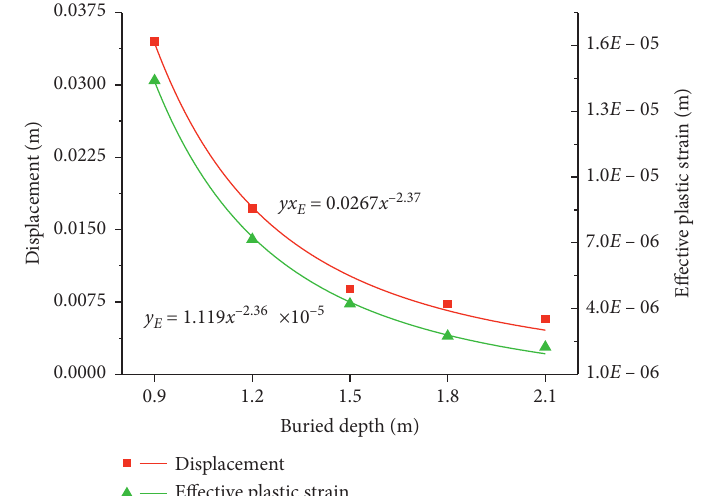
Figure 19: Dynamic response curves of